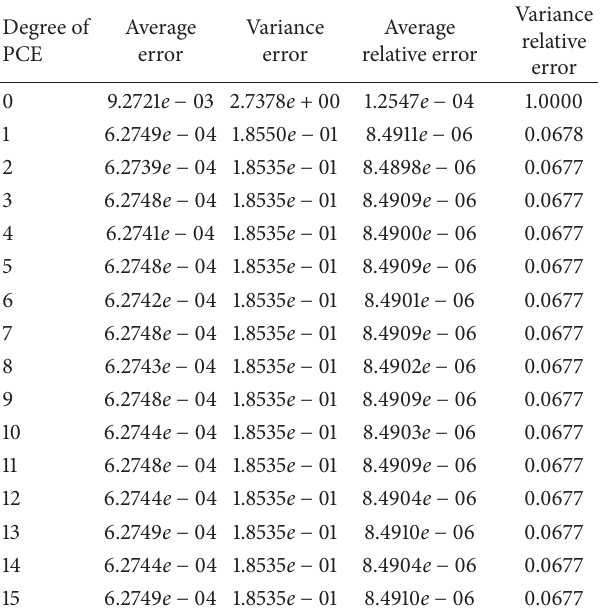
Table9:ErroroftheaverageandvarianceofthePCEapproximation of CIR model at time 𝑇 = 1 , with parameters 𝛼 = 0.1 , 𝛽 = 0.2 , = 110 𝜎 = 0.15 , and 𝑅 0